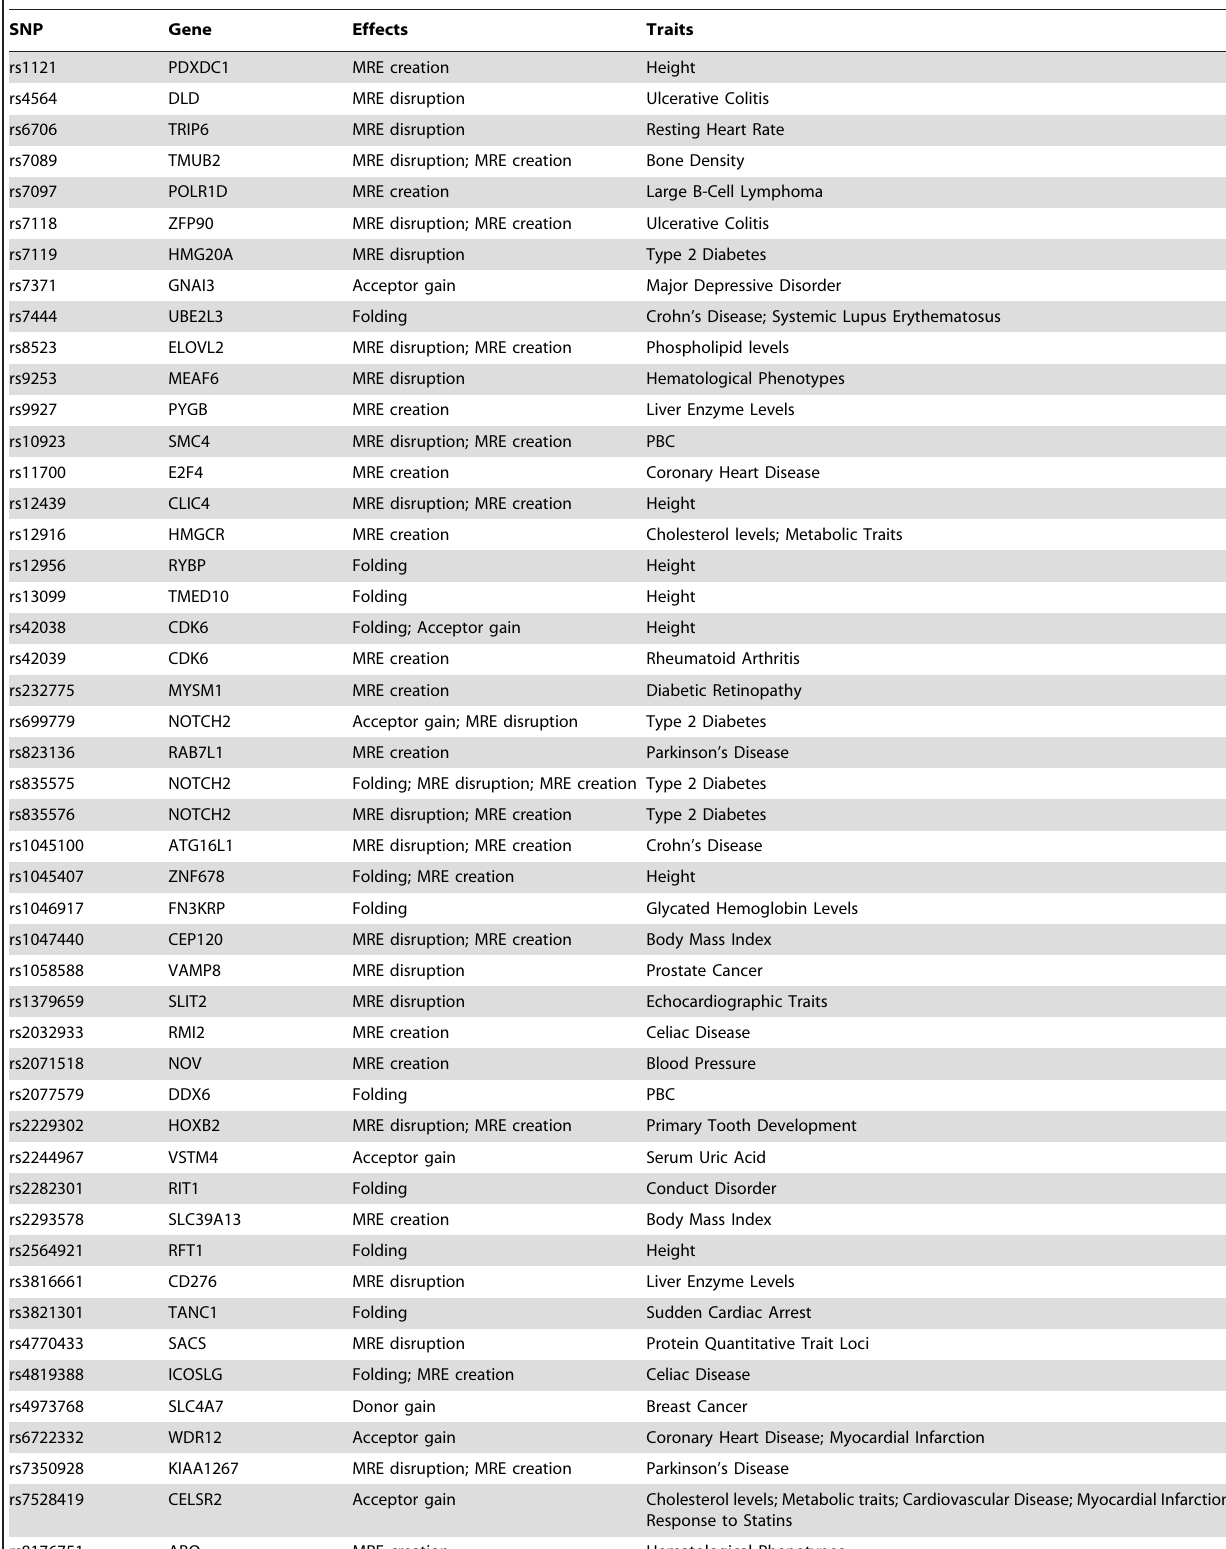
Table 1. SNPs affecting functional elements with cis -regulatory effects on miRNA